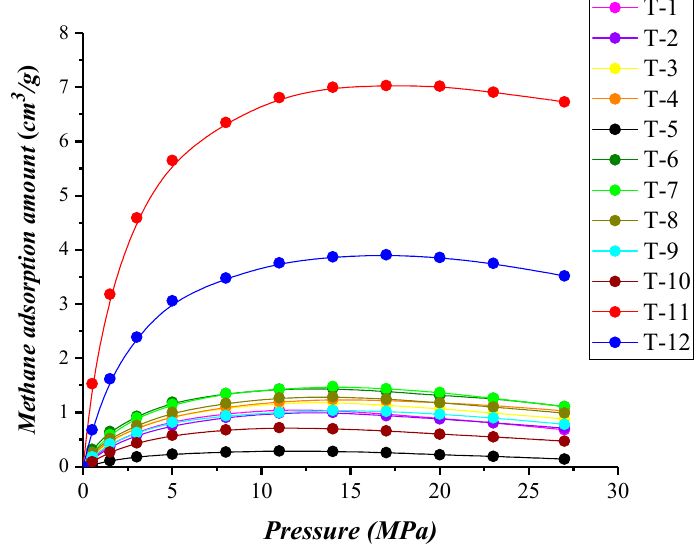
◦ C in the 12 shale samples, fitted using Equation Figure 7. Excess adsorption of methane at 55 °C in the 12 shale samples, fitted using Equation (1). Figure 7. Excess adsorption of methane at 55